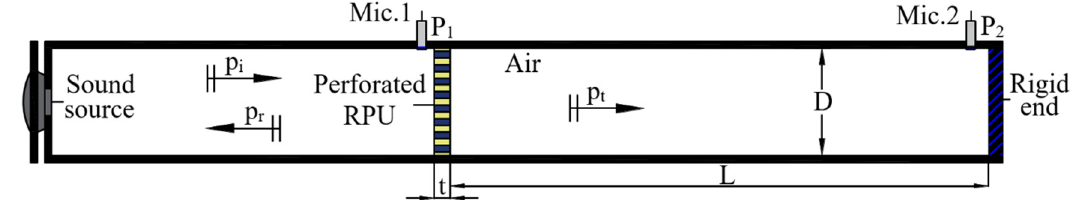
Figure 8. Schematic diagram of the impedance tube used to measure specific airflow resistance by Ingard and Dear method. L is the distance between the back face of the sample and the rigid end; t is the thickness of the sample; p t is the acoustic pressure of the transmitted wave.